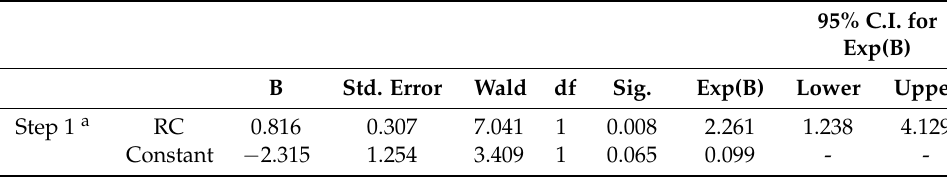
Table 25. Regulatory compliance: regression analysis for